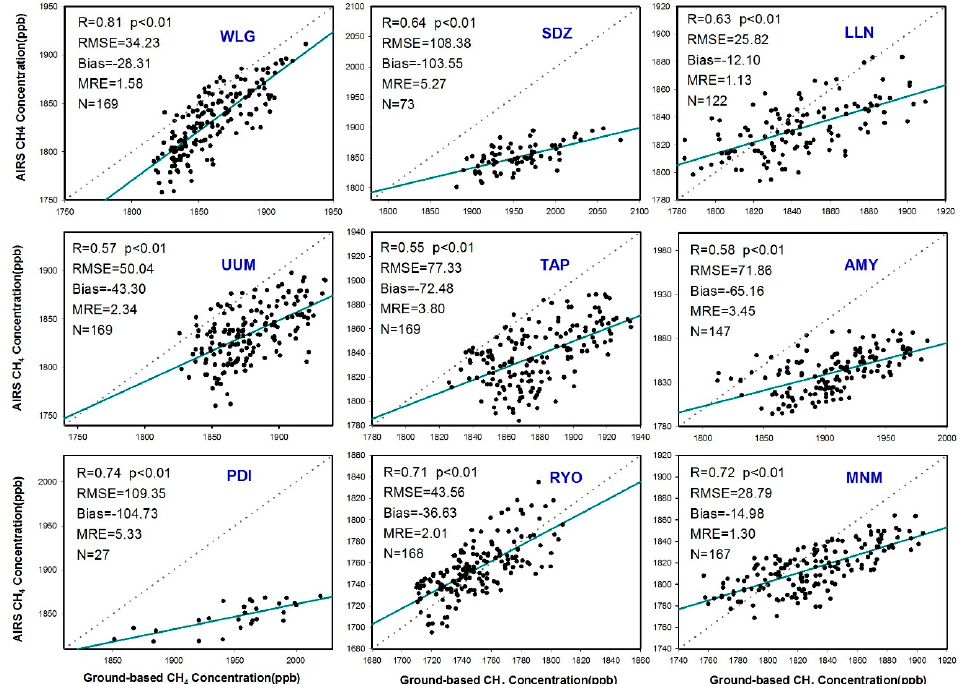
Figure 1. Scatter plots of the monthly averaged surface CH 4 concentrations from World Data Centre for Greenhouse Gases (WDCGG) and Atmospheric Infrared Sounder (AIRS) retrievals at nine sites around China, during September 2002 to September 2016, respectively (the gray dotted line denotes a 1:1 ratio line).